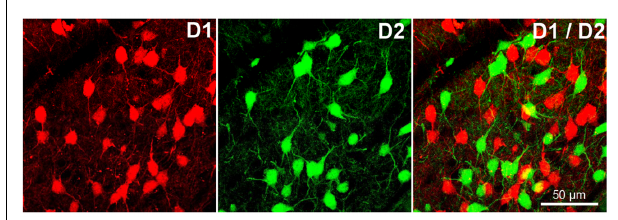
FIGURE 1 | D1 and D2 receptors are segregated in different cells in the striatum and in the nucleus accumbens. The first image (left) shows striatal cells of the direct striatonigral pathway expressing D1 receptors (specific reporter dtTomato under the control of D1R promotor). Second image (middle) show striatal cells of the indirect striatopallidal track expressing D2 receptors (specific reporter eGFP under the control of D2R promotor).The third picture (right) shows the lack of colocalization of D1 and D2 receptors in striatal cells (yellow parts of cells are cell overlap artifacts).